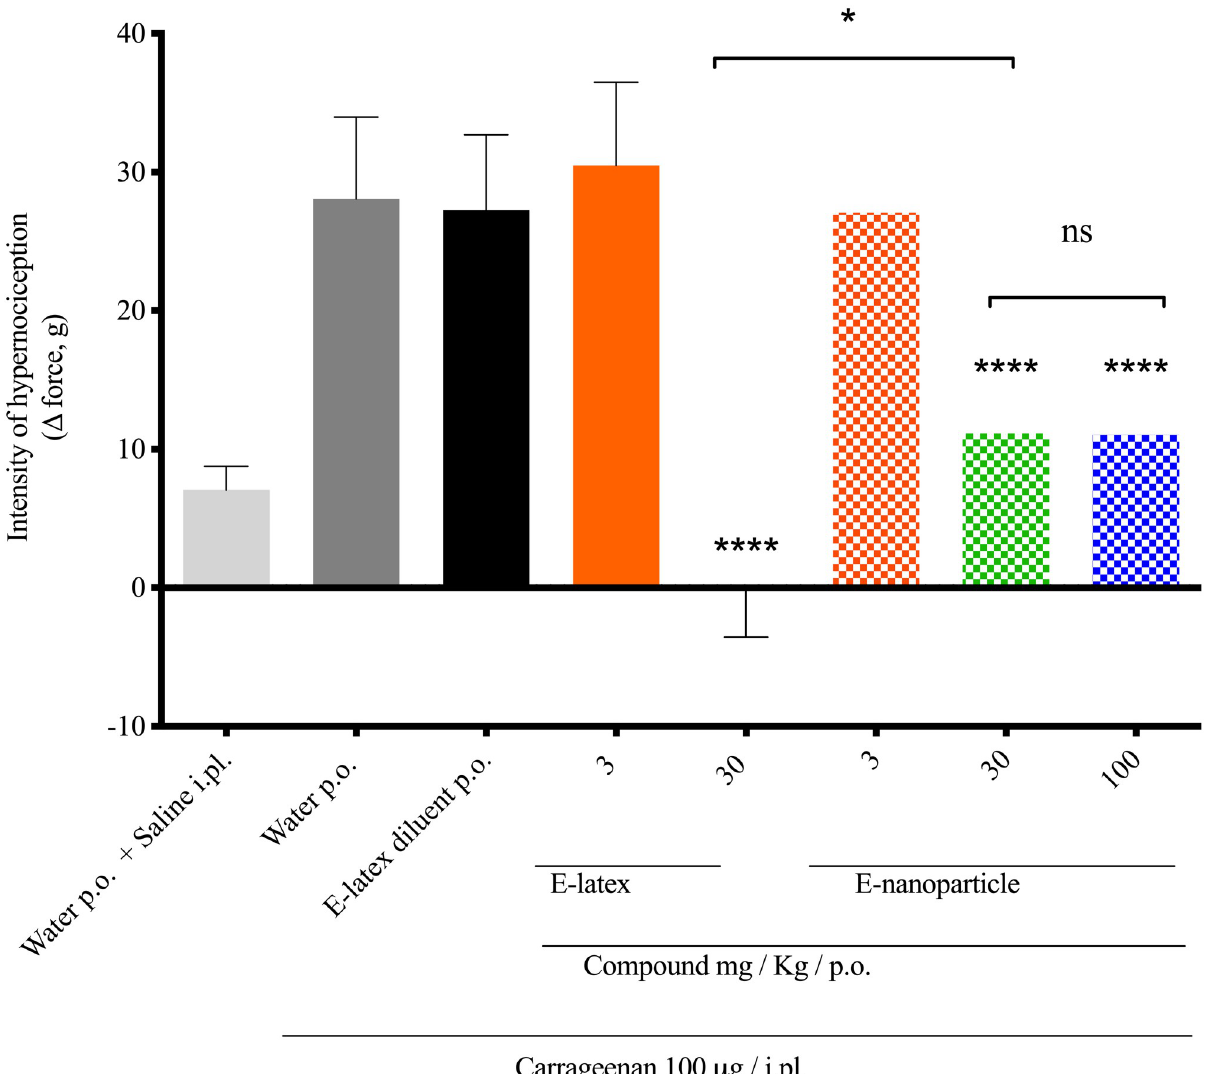
Fig 6. Carrageenan-induced hypernociception in rats is inhibited by the free or encapsulated compound.